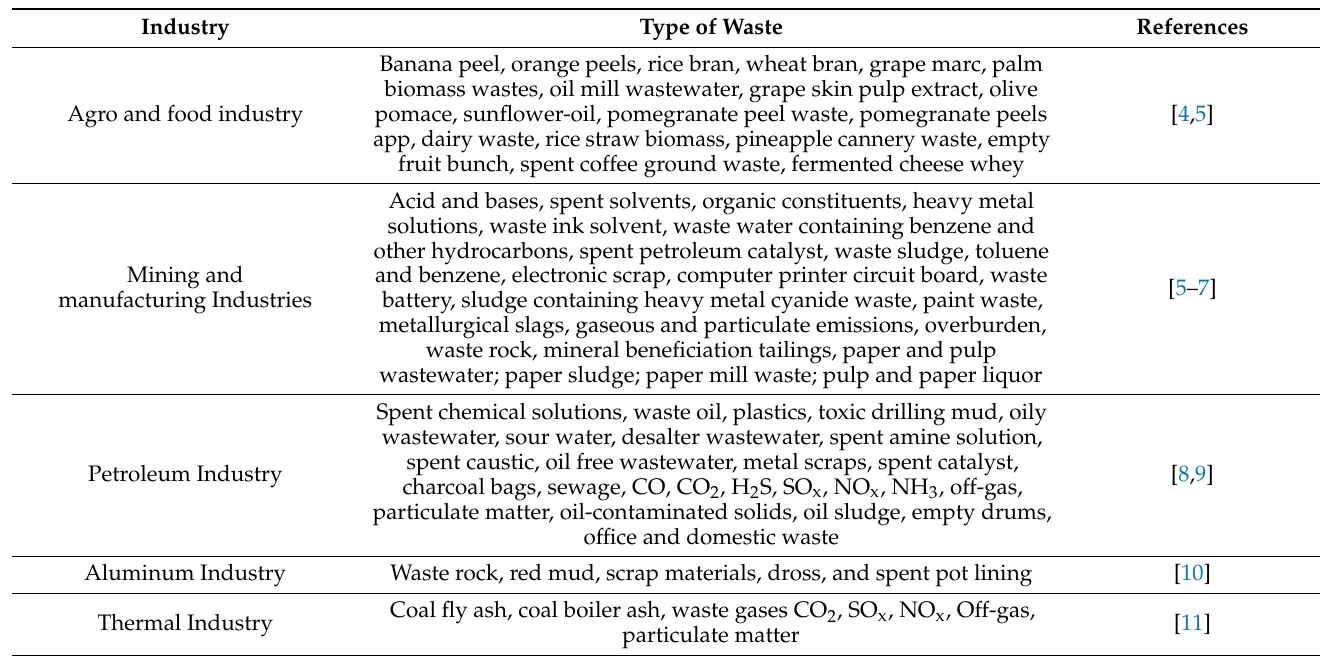
Table 1. Types of industrial waste.